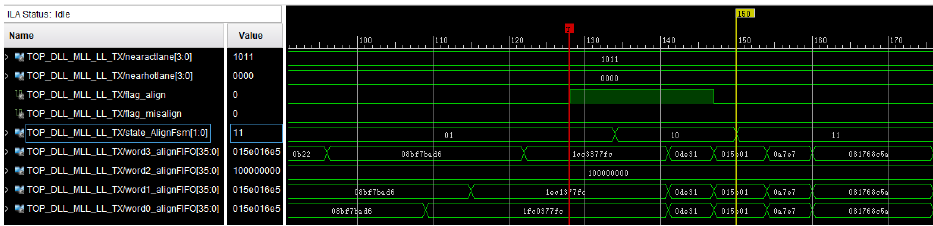
Figure 12. The ILA waveform of the modified word re-ordering block.